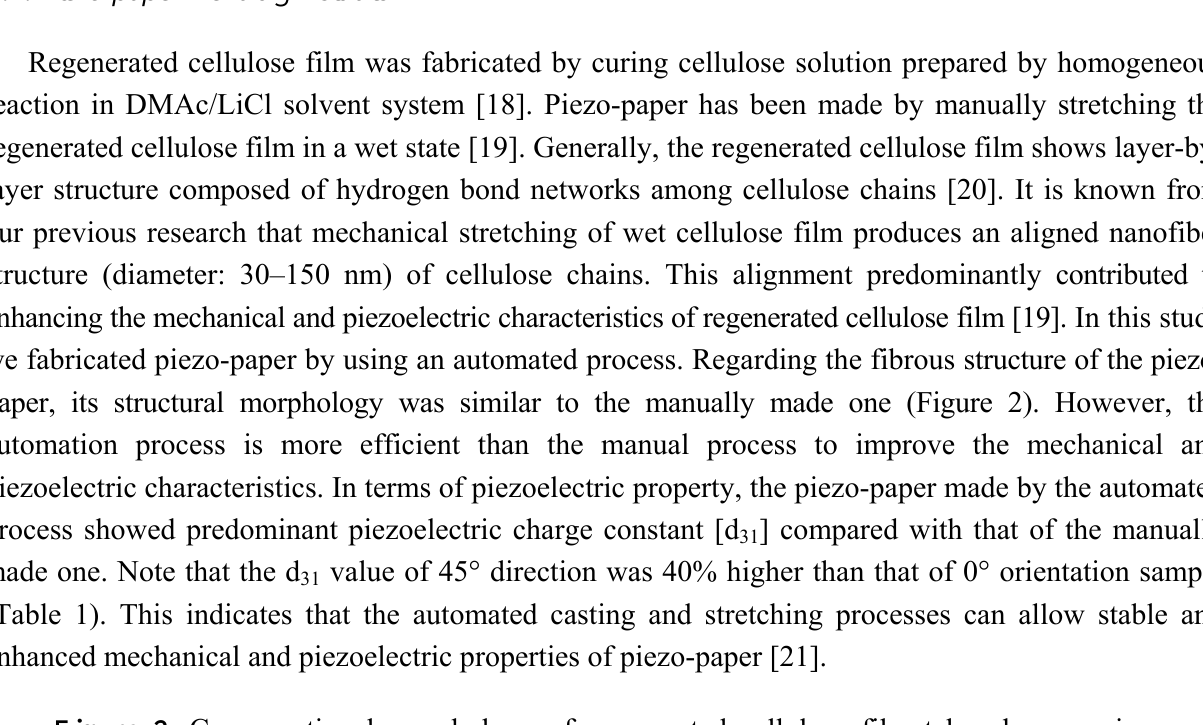
Figure 2. Cross-sectional morphology of regenerated cellulose film taken by scanning electron microscopy (SEM): a) before stretching and b) after stretching (S